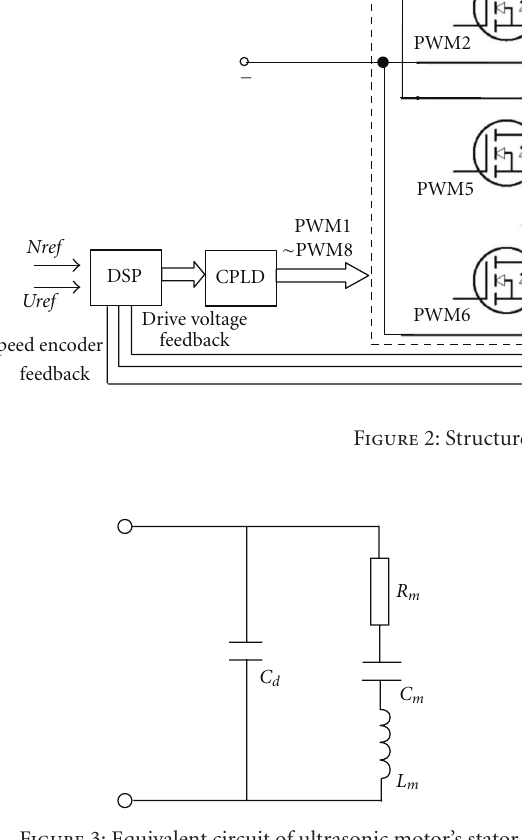
Figure 3: Equivalent circuit of ultrasonic motor’s stator.